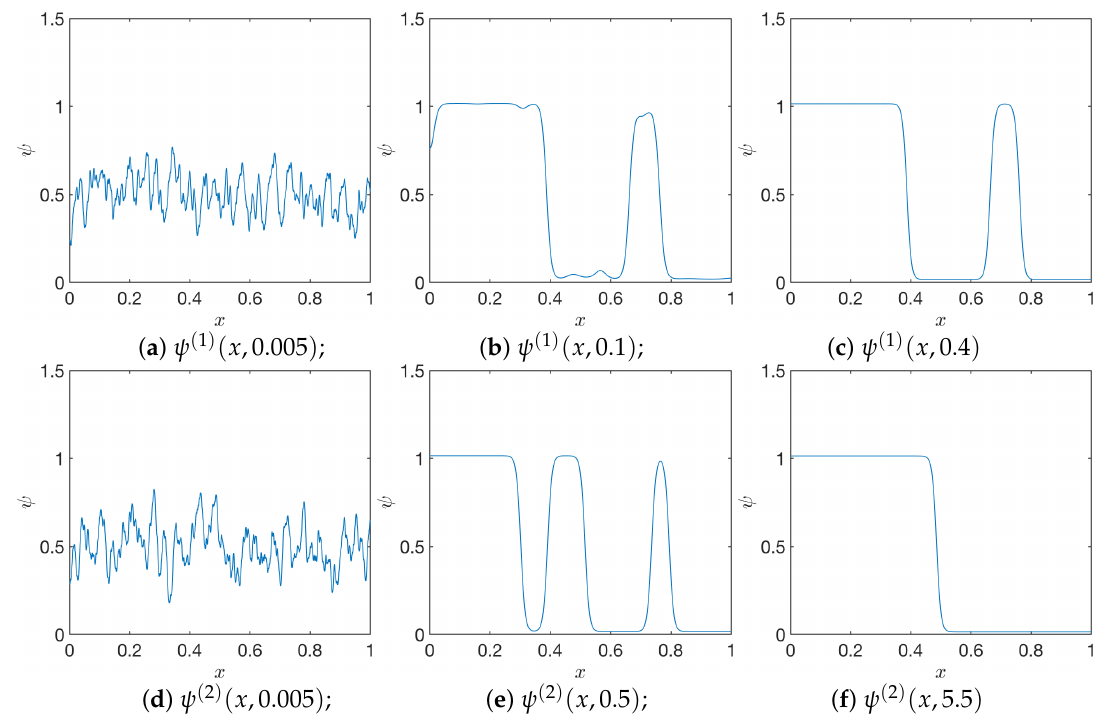
Figure A1. Solutions ψ ( i ) ( x , t ) to Example A1, corresponding to ψ times t . The right column is at t = T ∞ , different for each i .